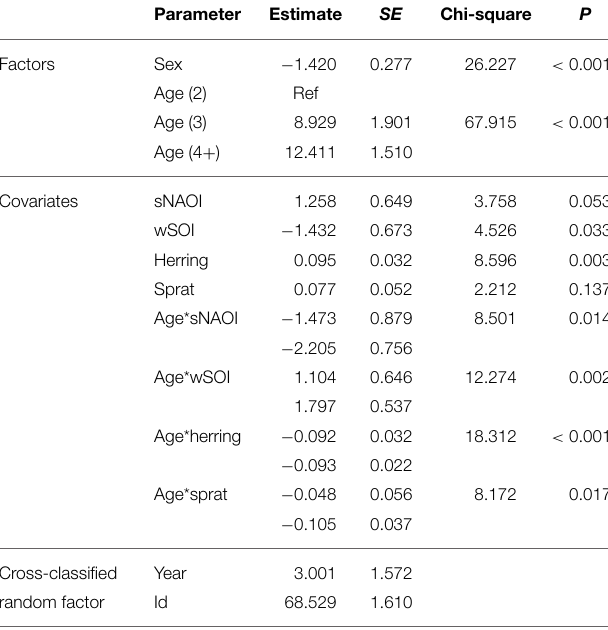
TABLE 3 | Minimal adequate additive cross-classified random effect model describing significant effects of age, sex and environmental covariates on arrival date of common terns (1994–2012).